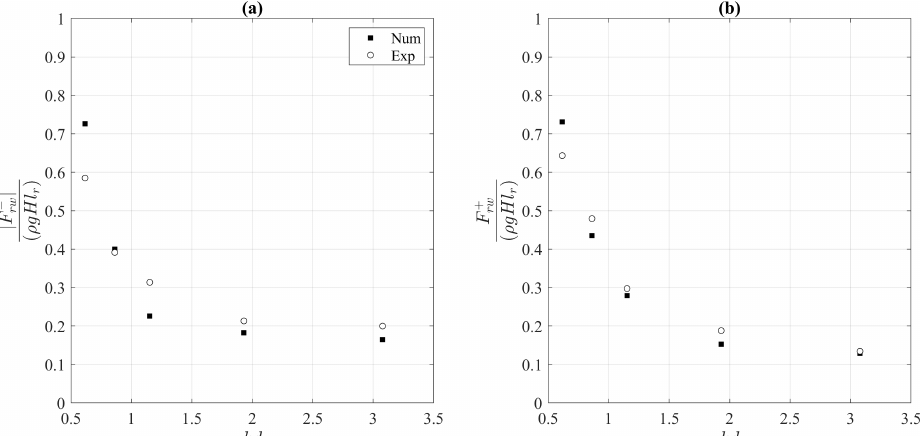
Figure 9. Comparison between the wave loading measured in the experimental campaign on the rear wall of the caisson and that estimated by the numerical model. F − rw ( a ) and F + rw ( b ) indicate the minimum and maximum wave loading respectively.